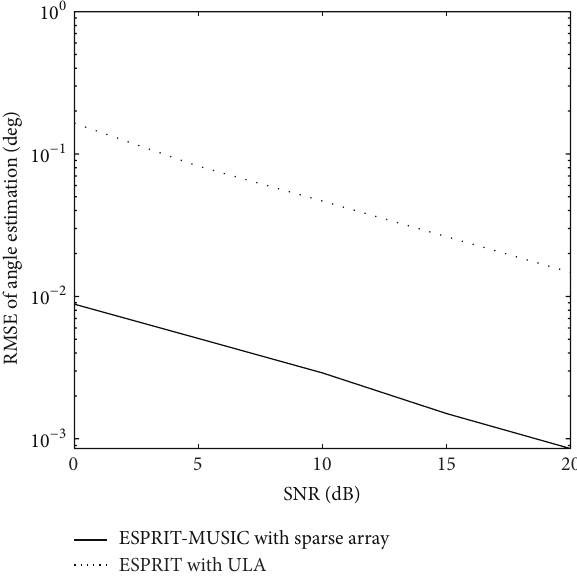
Figure 4: RMSE of angle estimation of the first